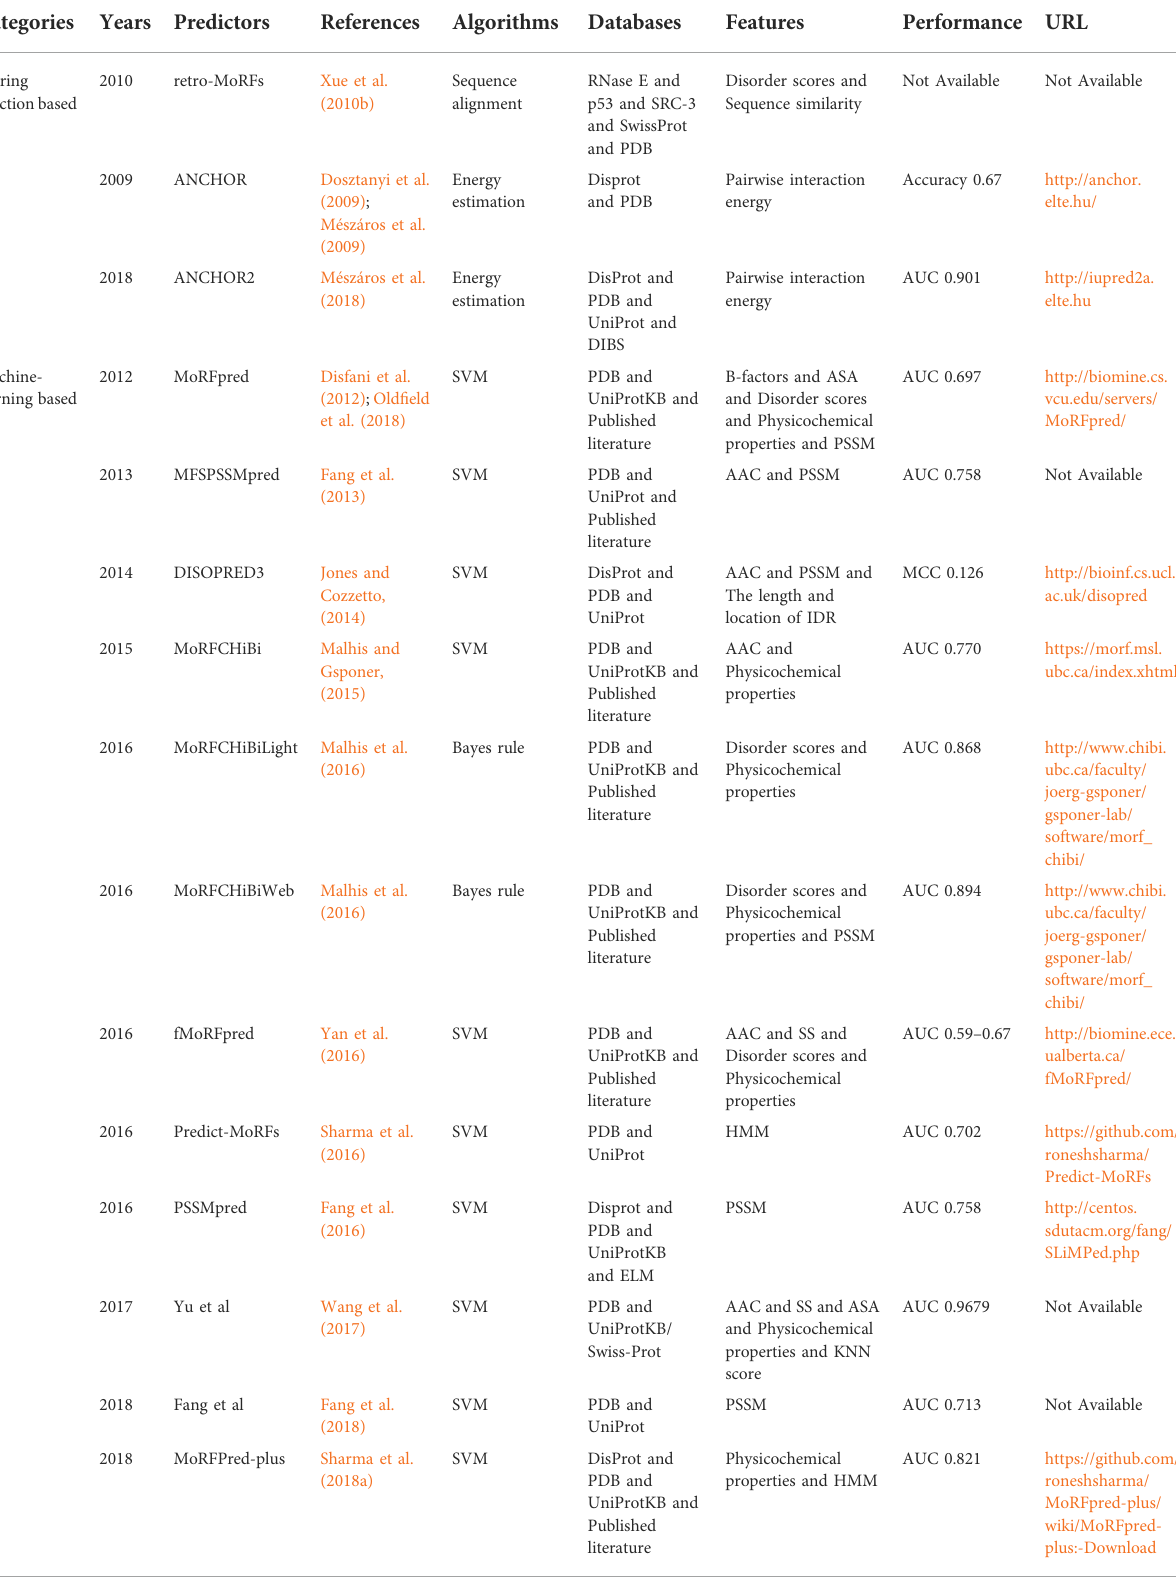
TABLE 2 Summary of intrinsically disordered protein-protein interaction sites